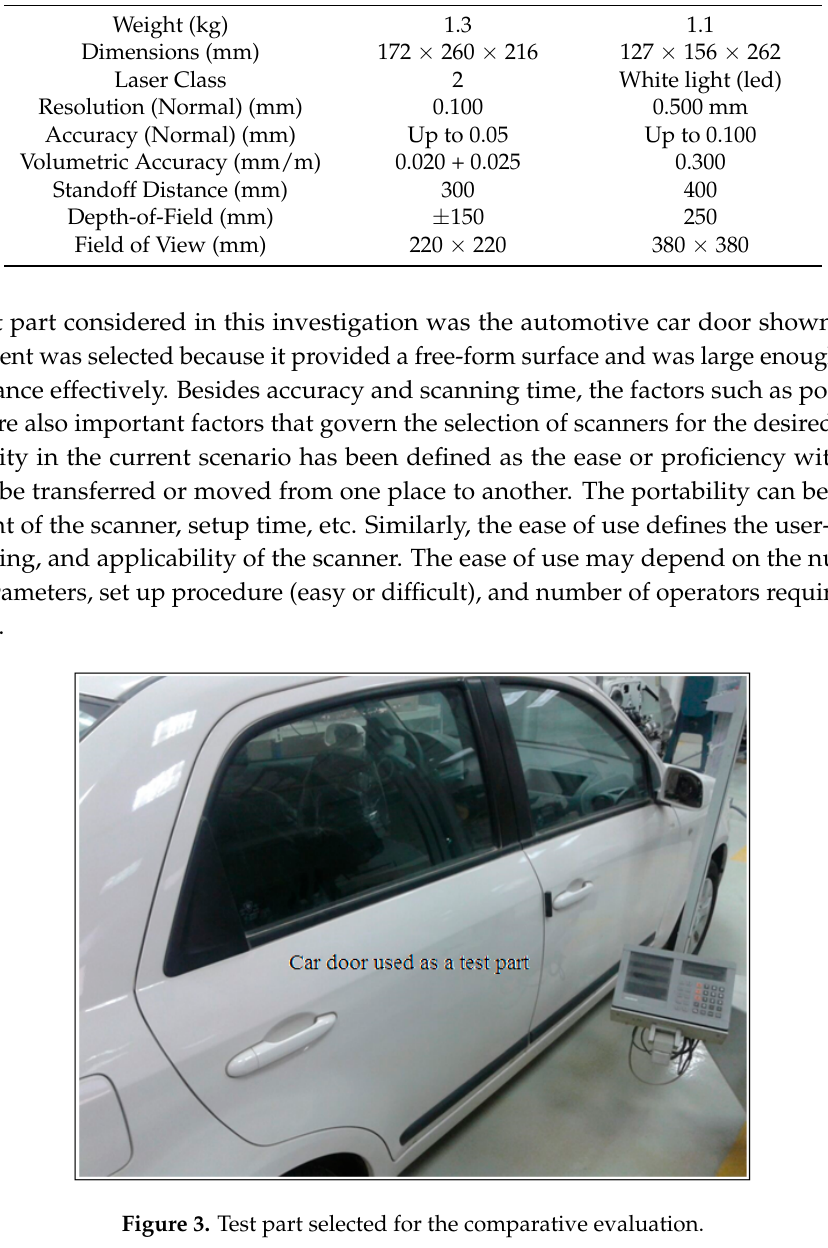
Table 1. Technical specifications of the two data acquisition systems.